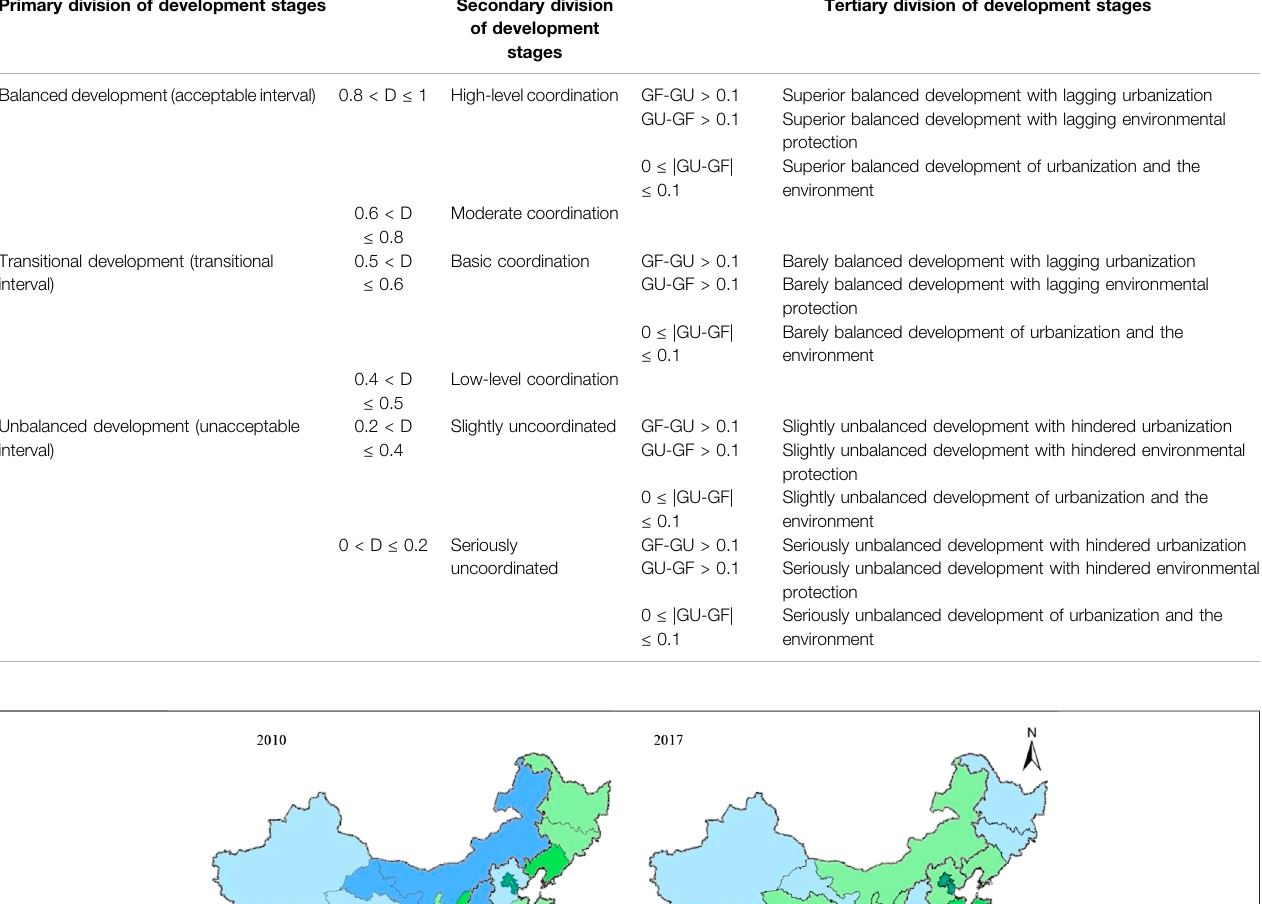
TABLE 3 | The classi fi cation of the coupling coordination degree between green urbanization and green fi nance.